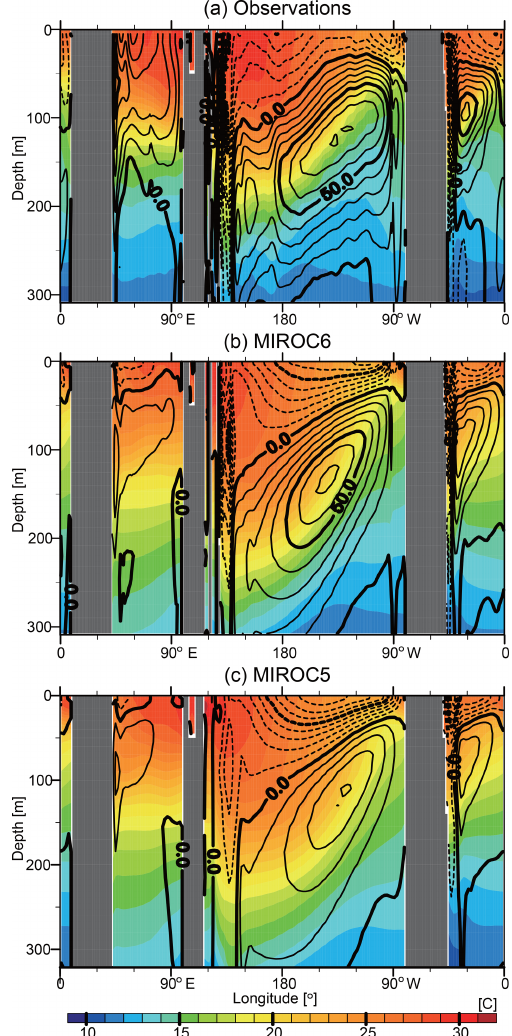
Figure 15. Annual mean climatology of potential temperature ( ◦ C; colors) and zonal current speed (cms − 1 ; contours) along the Equator (1 ◦ S–1 ◦ N) in (a) observations (ProjD and SODA), (b) MIROC6, and (c)